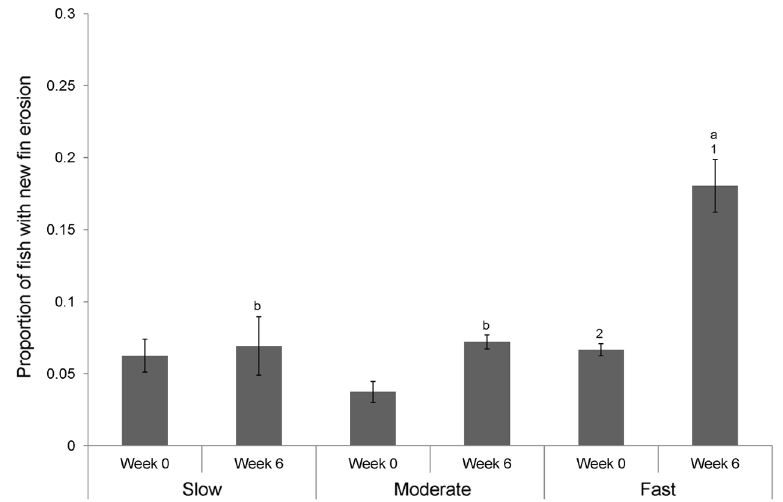
Fig. 4. Mean proportion of fish with new fin erosion at start and end of ex- periment in fish kept at slow (0.2 body length [BL] s −1 ), moderate (0.8 BL s −1 ) and fast (1.5 BL s −1 ) water current velocities. Error bars represent SE. Lower- case letters denote significant differences between current velocities, and numbers denote significant differences between weeks (p < 0.05)